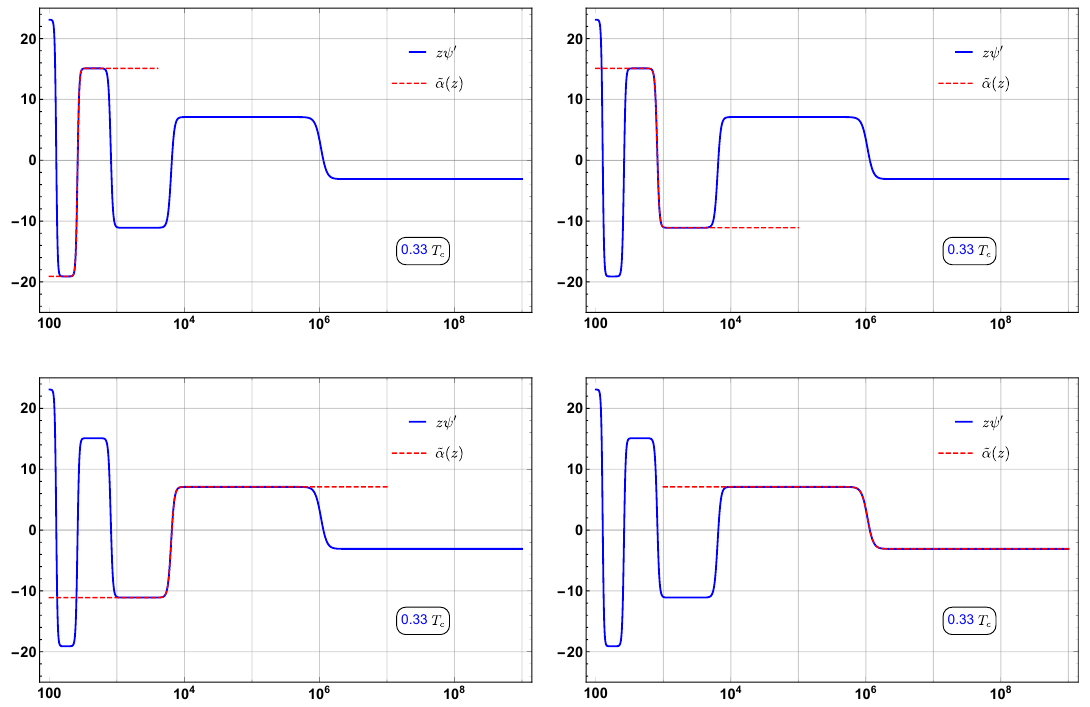
for which there are at least four c